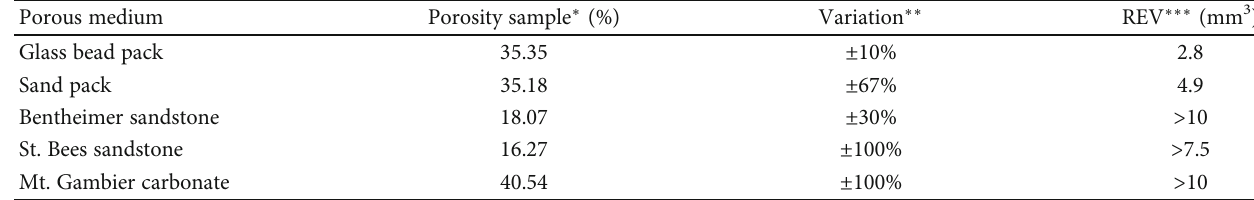
Table 3: Porosities and REV properties of the fi ve samples